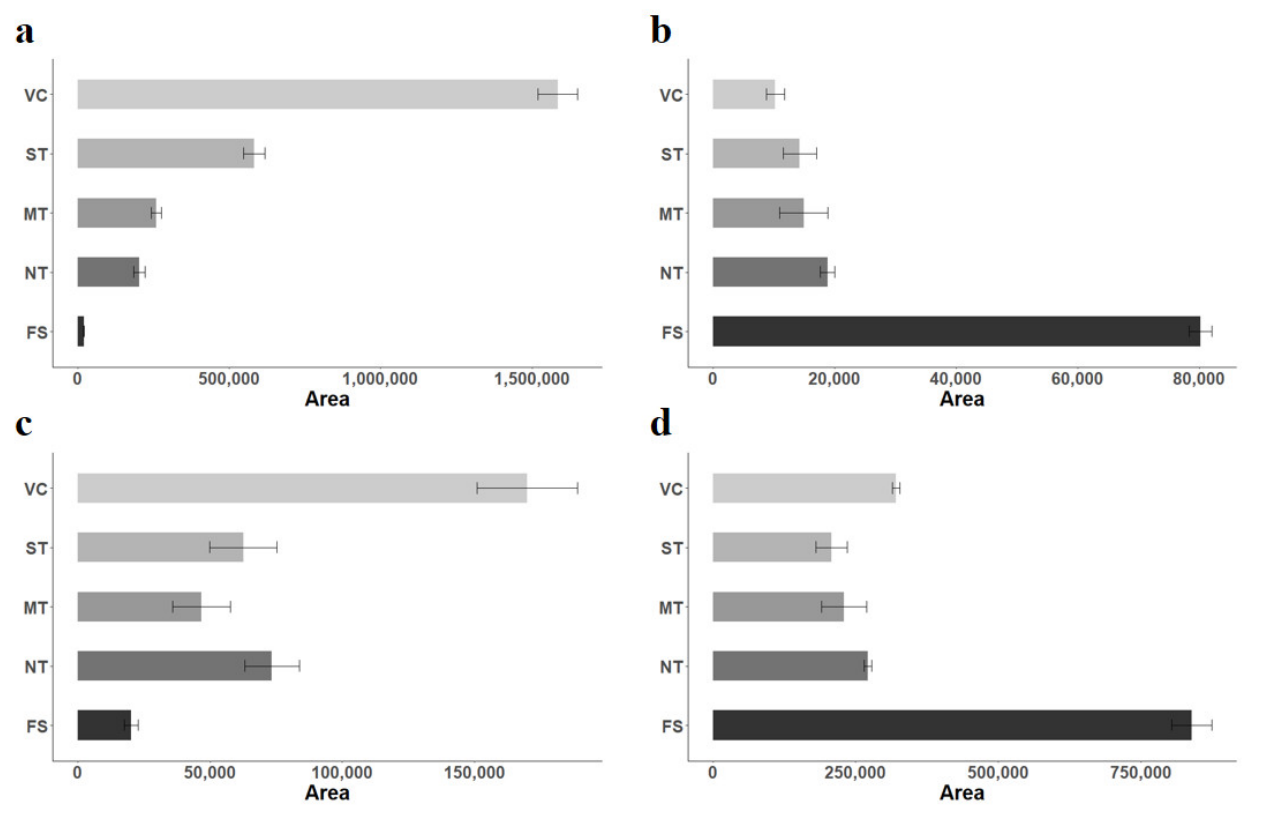
Figure 2. Bar plot of the metabolites identified in strawberry puree across the processing sample groups. X-axis: total abundance of the metabolite; Y-axis: treatment. ( a ) Pyroglutamic acid; ( b ) Pteroyl-D-glutamic acid; ( c ) 4-hydroxy-3-methoxy benzoic acid; ( d ) 2-hydroxybenzoic acid β-D-glu- coside. Strawberry samples: Fresh strawberries (FS), No heat treatment (NT), mild heat treatment (MT), standard thermal treatment, vacuum concentration (VC).